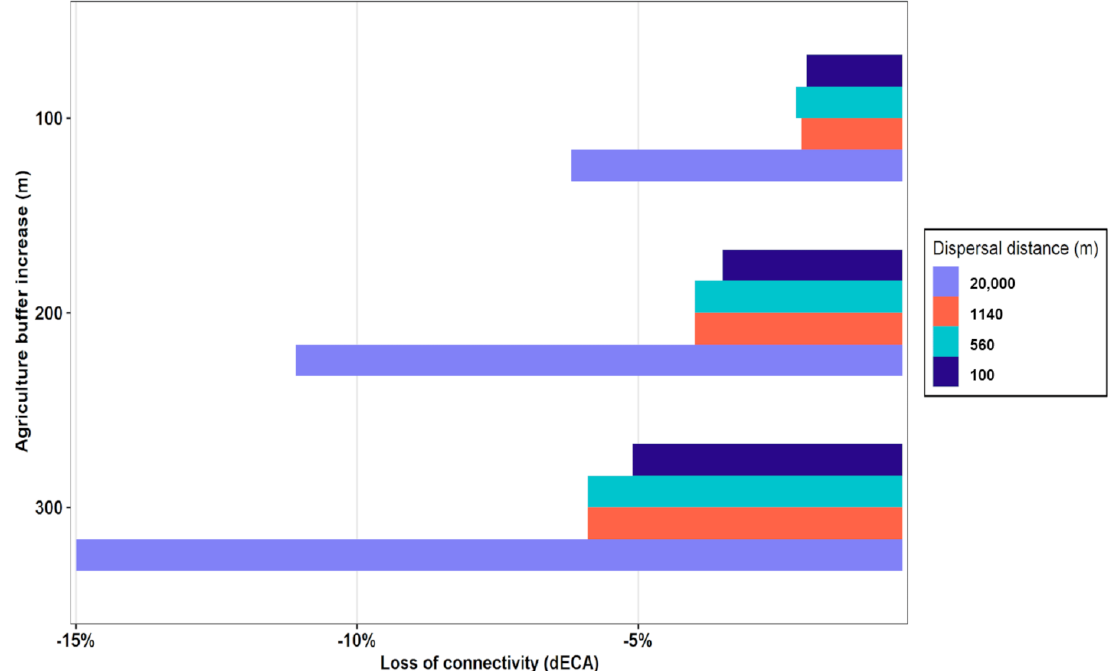
Figure 6. Relative changes (%) in connectivity ( dECA ) given by the effect of the hypothetical increase in agricultural area in the studied landscape, given different dispersal distances used to calculate